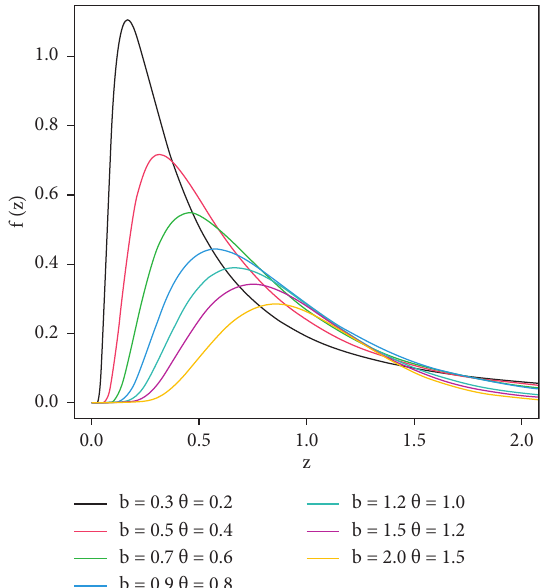
Figure 1: The pdf of the TIIFILi model for various parameter values.